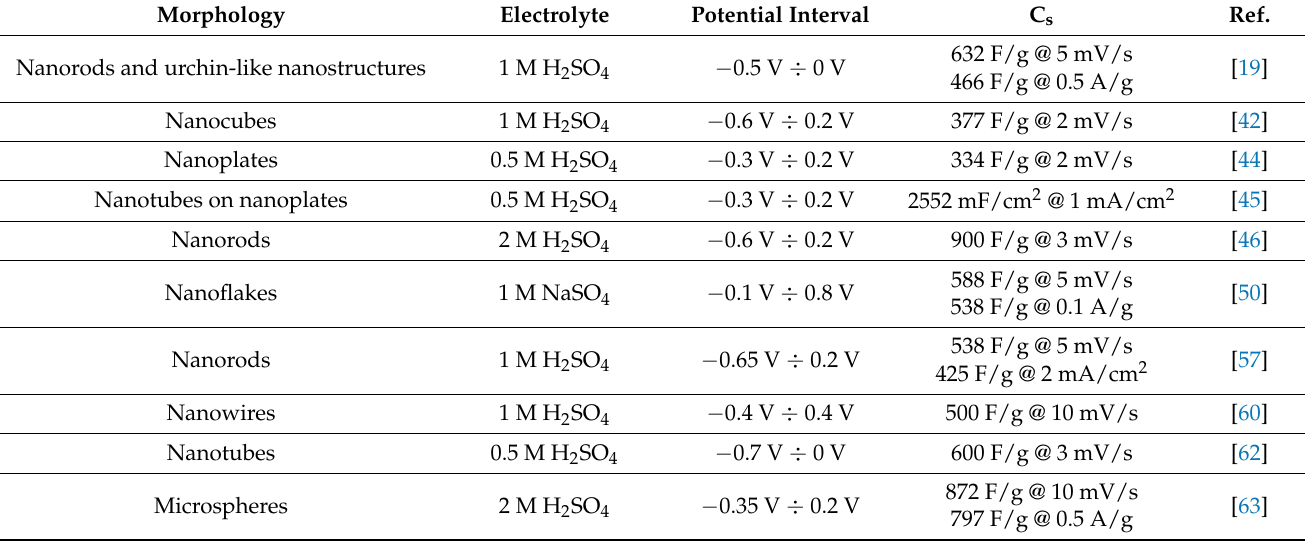
Table 1. State-of-the-art on energy storage applications of WO 3 nanostructure-based electrodes. Morphology Electrolyte Potential Interval C s